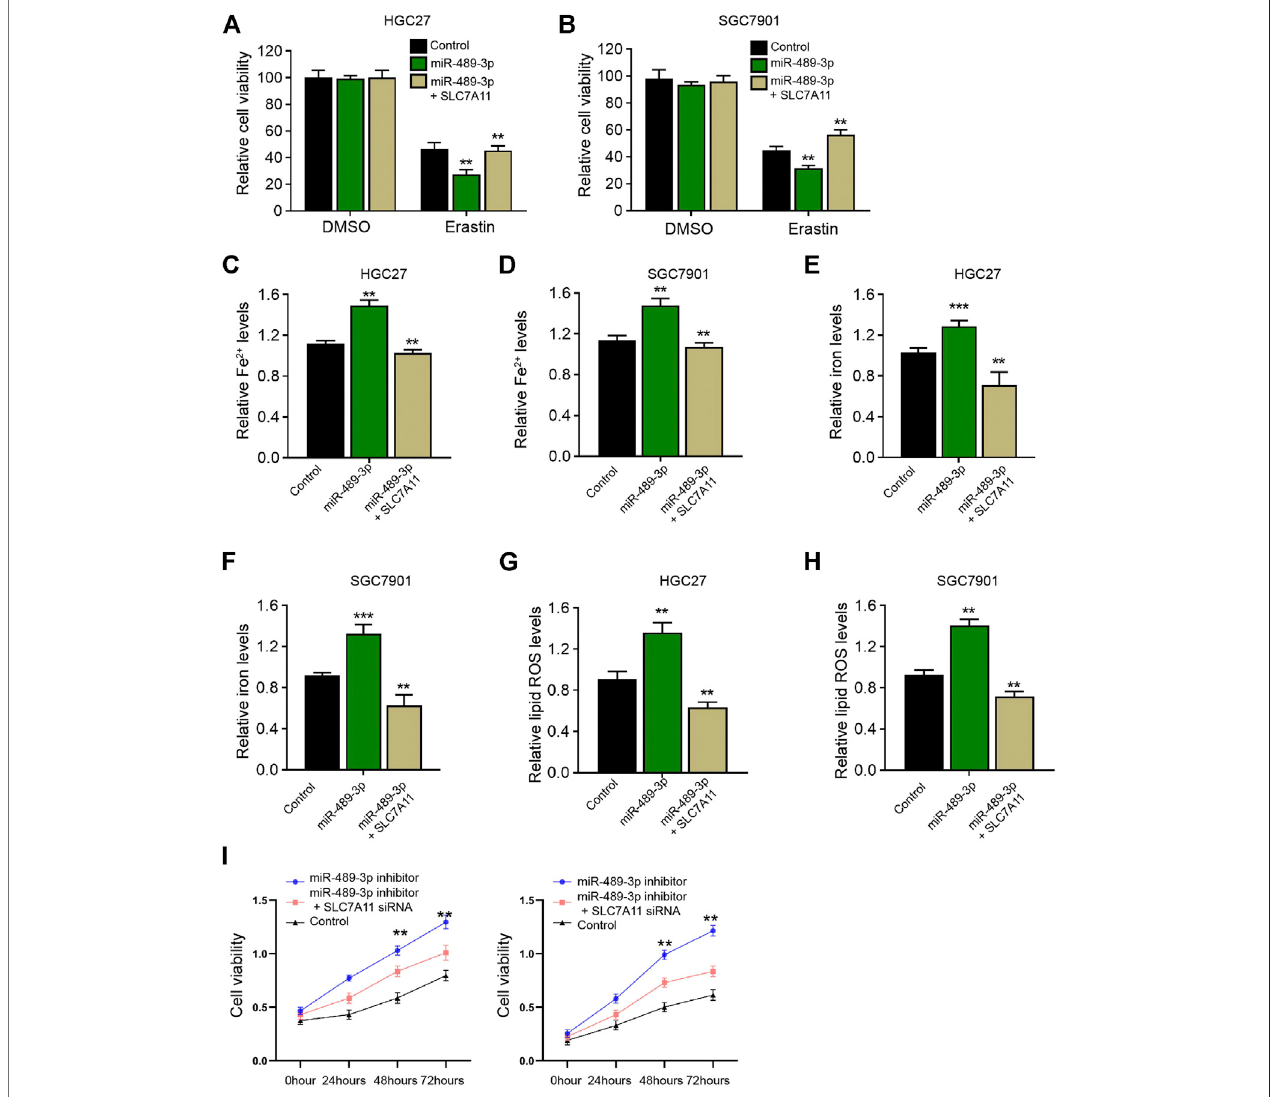
FIGURE7| SLC7A11isinvolvedinmiR-489-3p-induced ferroptosisofgastriccancercells. (A – H) Theerastin(5 μ M)-treated HGC27andSGC7901cellswereco- treatedwith miR-489-3p mimic and SLC7A11 overexpression vectors. (A,B) MTT assaysfor cell viability analysis. TheFe 2+ (C,D) , iron (E,F) , and ROS levels (G,H) were analyzed (I) . The erastin (5 μ M)-treated HGC27 and SGC7901 cells co-treated with miR-489-3p inhibitor and SLC7A11 siRNA. The cell viability was detected by MTT assays. The experiments were performed independently three times (mean ± SD, ** p < 0.01).